Question: Briefly state, in one sentence, what is plotted here.
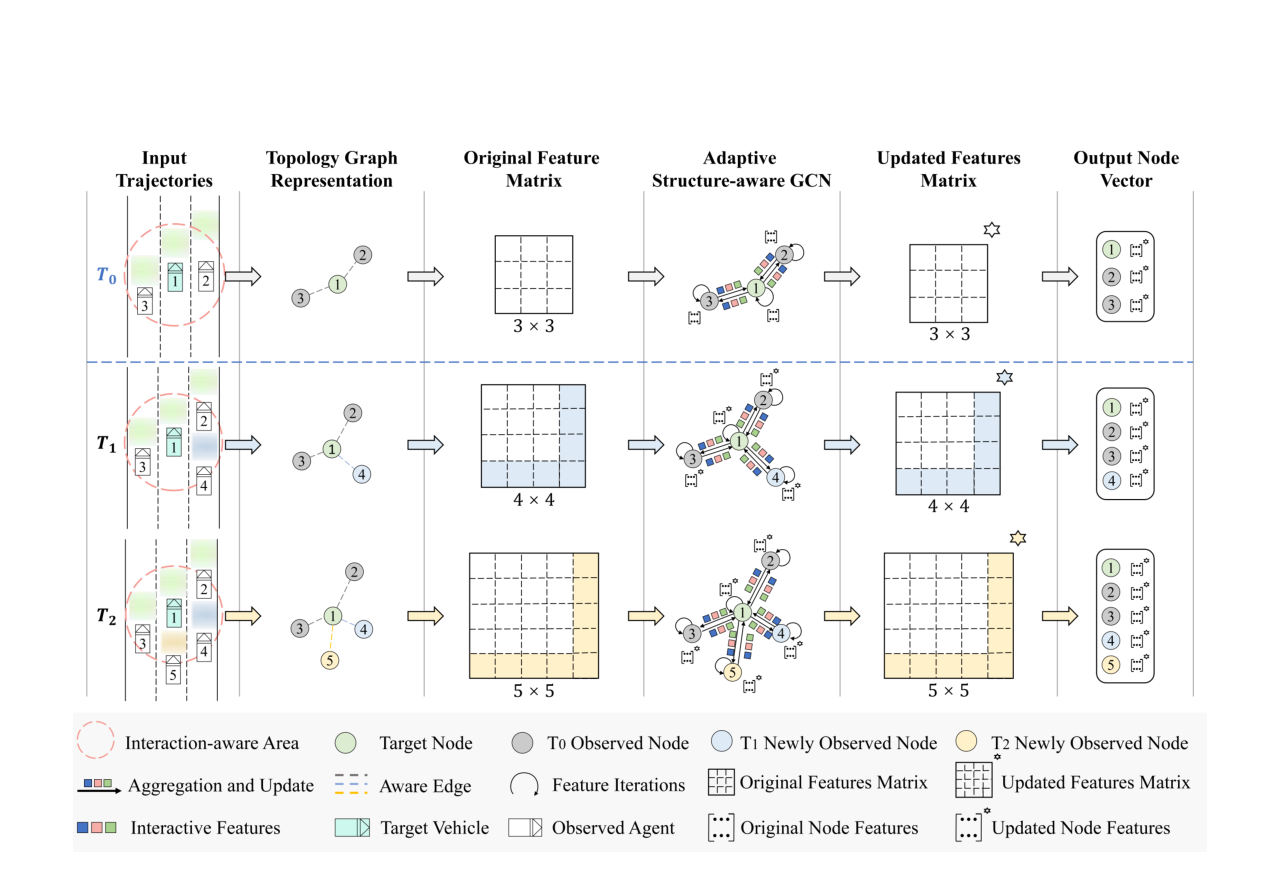
Answer: Overview of our adaptive structure-aware GCN. The real-time trajectories of the target and observed agents are captured using a topology graph to form a feature matrix. This matrix undergoes aggregation, updating, and iteration within the GCN. As new agents are observed in real-time, the GCN dynamically adjusts its topology, updating features for the added nodes.